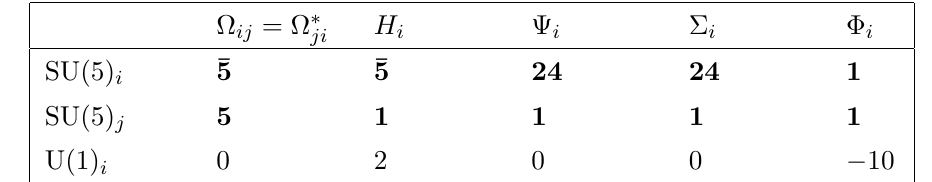
Table 2 . Scalar (cid:12)eld content ( i; j = 1 ; 2 ; 3 and i